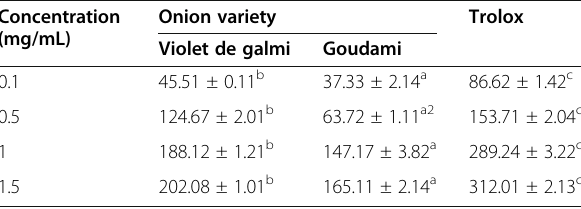
Table 2 Antioxidant content of aqueous extract of onion bulb Parameters